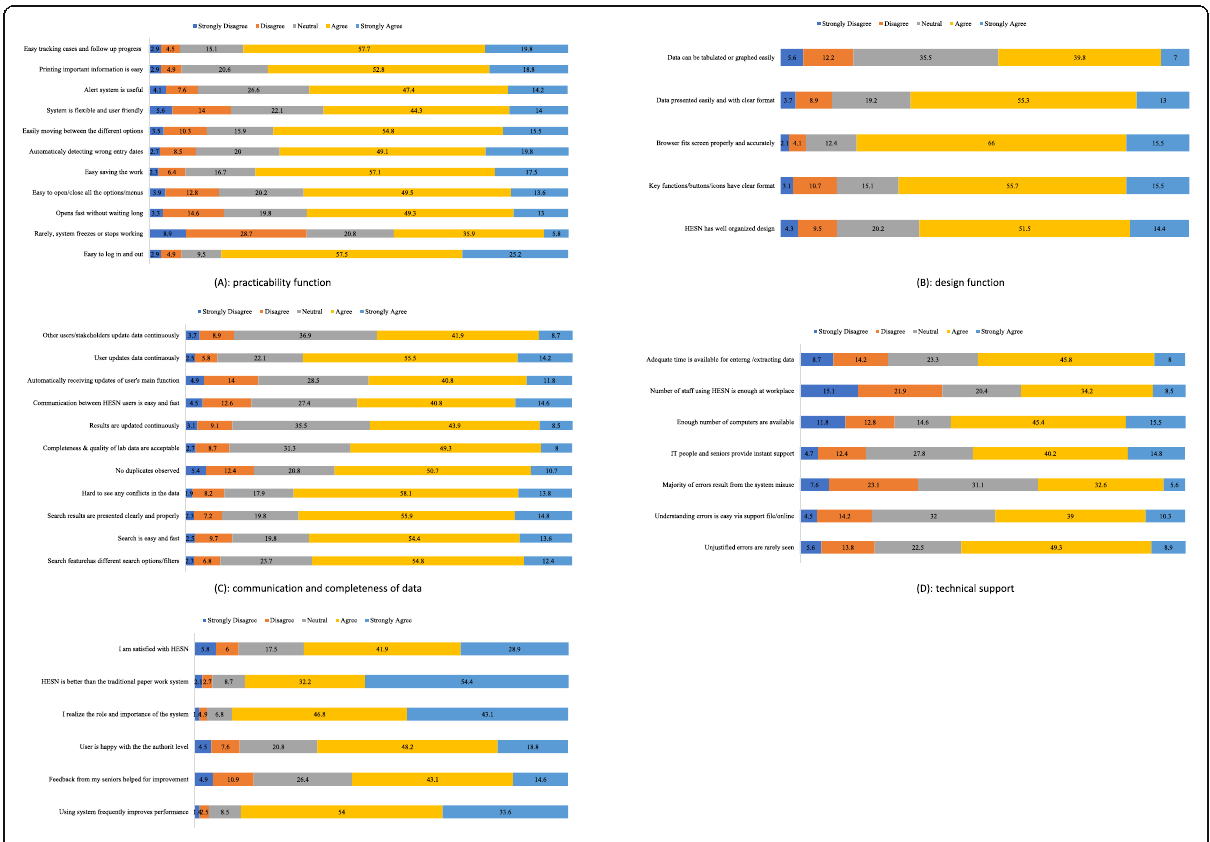
Fig. 2 User ’ s perception and experience regarding the functionality of HESN. A Practicability, B Design, C Communication and completeness of data, D Technical support, and E General